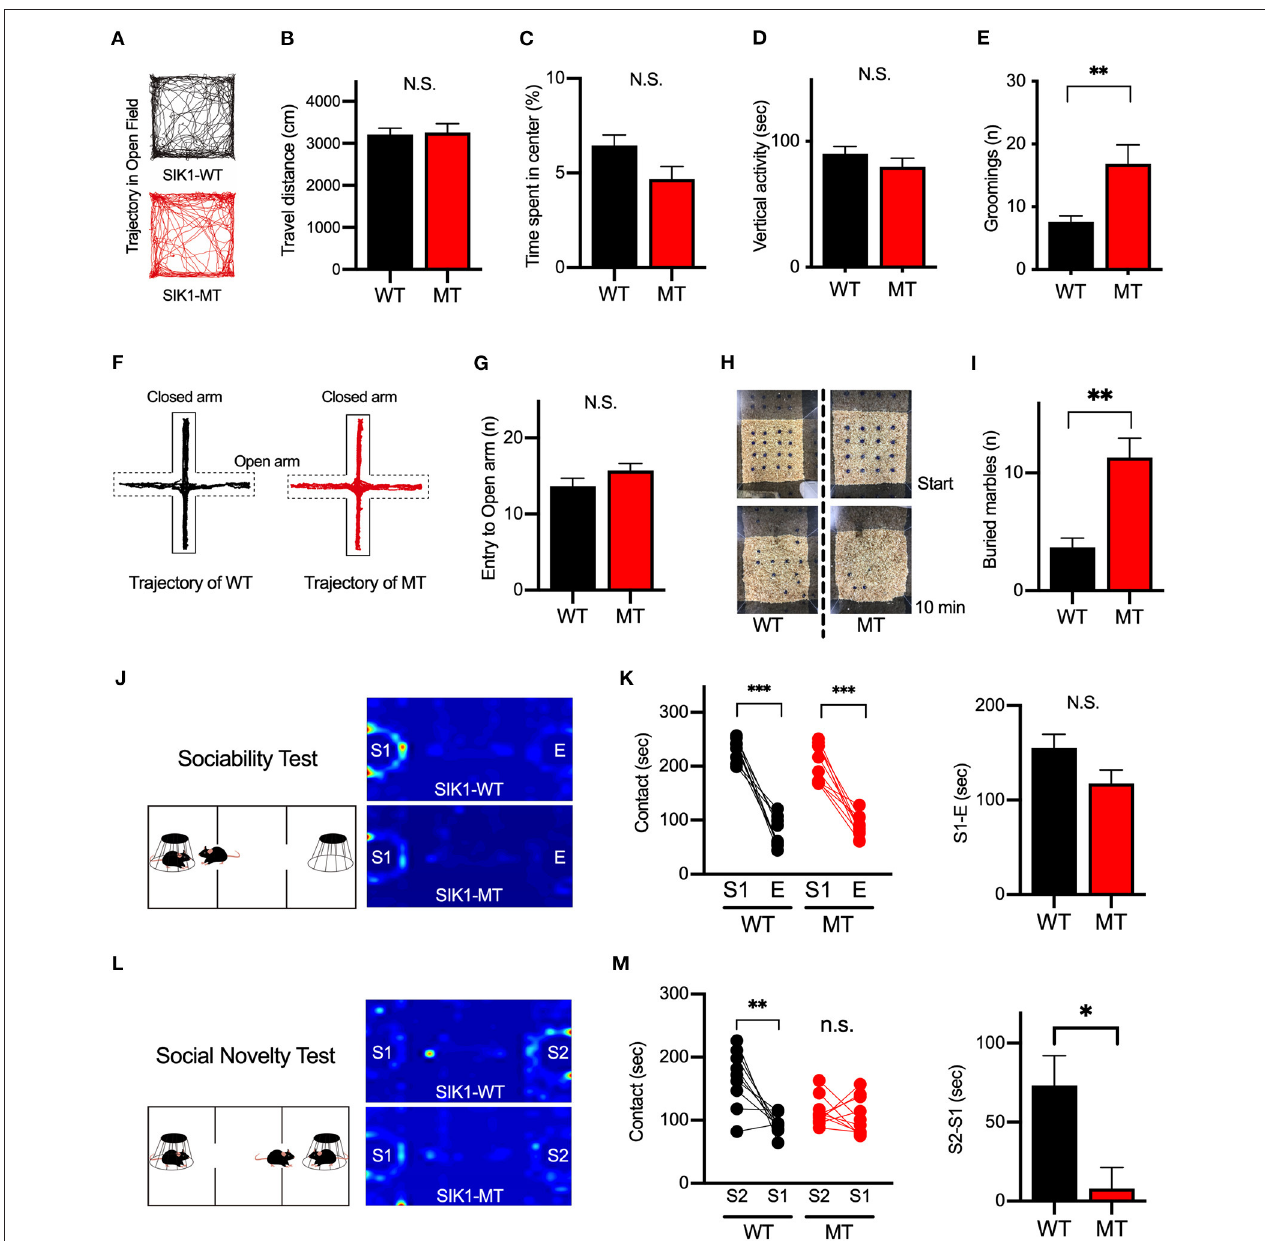
FIGURE 3 | Repetitive and social behaviors were altered in SIK1-MT mice. (A) Trajectories of movement of SIK1-WT and -MT mice in the open field arena. (B) Total travel distance of SIK1-WT ( n = 9) and -MT ( n = 7) mice. (C) The percentage of the time spent in the center of the arena. (D) The total time of vertical activities in the open field. (E) The number of grooming during the observation period. The number of grooming was increased in SIK1-MT mice. (F) Moving trajectories of mice on the elevated plus-maze. (G) The number of entries into open arms of the elevated plus-maze. The number of the entry was unchanged in SIK1-MT mice. (H) The top views of the marble burying test field. Sixteen marbles were placed at the start of the test (top). Buried marbles were counted after 10–min of the test (bottom). (I) The numbers of marbles buried under the woodchip after the test. SIK1-MT mice buried more marbles in this test. (J) The sociability test evaluating the sociability by the time spent with the empty cage (E) vs. the cage with a stranger mouse (S1). Heatmaps represent the stay time of the test mouse. (K) Both WT and SIK1-MT mice interacted more with S1 than E and the preference to E vs. S1 was similar between these mice (graph). (L) Social novelty test evaluating social memory by the time spent with the stranger mouse (S1) versus novel stranger mouse (S2). Heatmaps represent the stay time of the test mouse. (M) WT mice interacted more with S2 than with S1, whereas the preference to S2 was significantly decreased in SIK1-MT mice (graph). Statistical analysis was made by Student’s t -test. Statistical significance was indicated by asterisks (* p < 0.05, ** p < 0.01, and *** p <